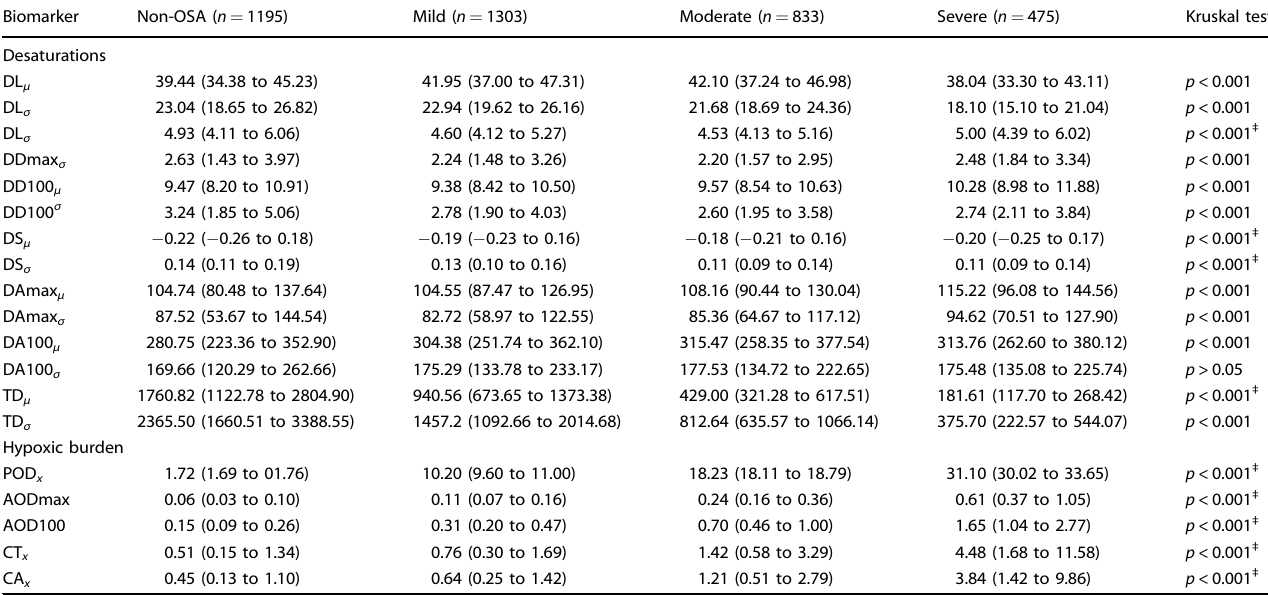
Table 2. Summary statistics (median and interquartiles Q1 – Q3) for the Desaturations and Hypoxic Burden OBMs evaluated on the SHHS1 database.